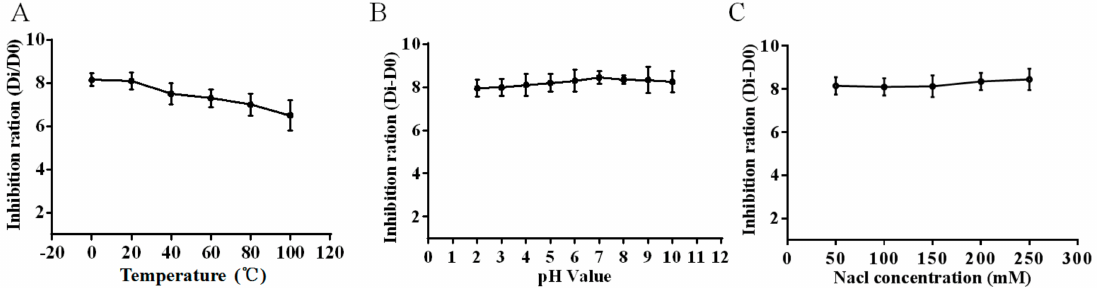
Figure 2. Stability detection of antimicrobial peptide HJH-1. ( A ) Thermal stability test. ( B ) pH stability test. ( C ) Ionic strength stability test. All data are presented as the mean ± SD ( n = 3).